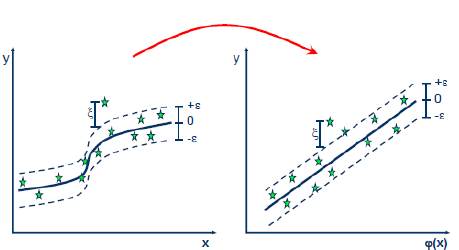
Figure 6. Nonlinear SVR method (Sayad, 2019)